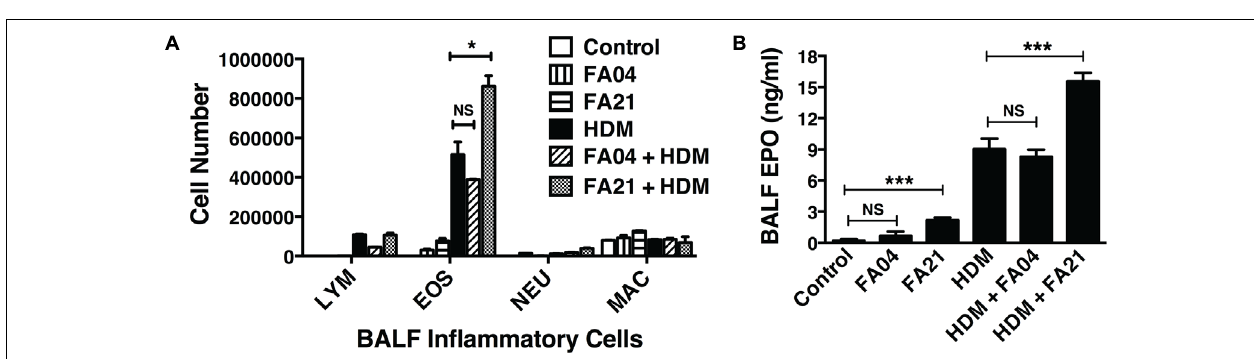
FIGURE 7 | The effect of exposure to MWCNT with high or low nickel content in exacerbating allergic lung inflammation. To compare the effects of high (FA21) or low (FA04) nickel MWCNT exposure on allergic airway inflammation, C57BL/6 mice (four per group) were intranasally challenged with PBS (control) or HDM allergen over a 2-week period (on days 0, 7, and 14) to induce allergic inflammation and then exposed to vehicle, FA21 or FA04 (50 µ g of MWCNT) on day 15 by intratracheal administration (illustrated in Figure 1 ). BALF was collected 24 h after MWCNT administration on day 16 for analysis of the airway inflammatory response. Groups comprised of mice treated with FA21 alone, FA04 alone, HDM alone, FA21 + HDM, FA04 + HDM, and carrier alone (control). (A) Cell differential counts in the BALF were determined and expressed as absolute cell numbers (per mouse) of lymphocytes (LYM), eosinophils (EOS), polymorphonuclear neutrophils (NEU), and macrophages (MAC). (B) The level of eosinophil infiltration was determined by measuring BALF cell-associated EPO using colorimetric analysis. Results are mean ± SEM ( n = 4), ∗ p < 0.05 and ∗∗∗ p < 0.001. Data are representative of three independent